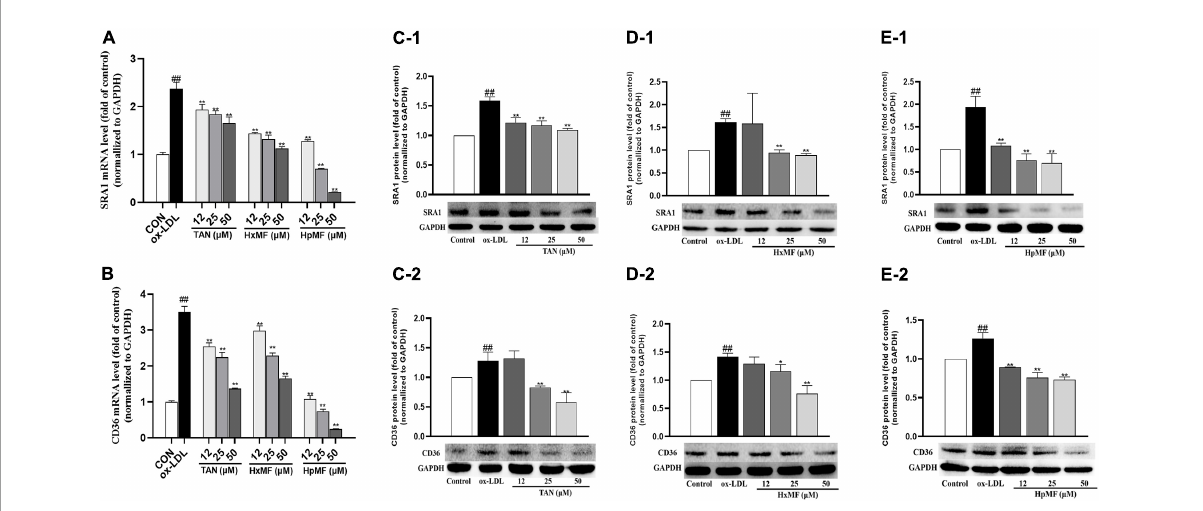
FIGURE5 Effects of TAN, HxMF, and HpMF on mRNA expression of SRA1 in ox-LDL-treated RAW264.7 cells (A) ; effects of TAN, HxMF, and HpMF on mRNA expression of CD36 in ox-LDL-treated RAW264.7 cells (B) ; effects of TAN on SRA1 and CD36 protein expression in ox- LDL-treated RAW264.7 cells (C1,C2) ; effects of HxMF on SRA1 and CD36 protein expression in ox-LDL-treated RAW264.7 cells (D1,D2) ; and effects of HpMF on SRA1 and CD36 protein expression in ox-LDL-treated RAW264.7 cells (E1,E2) . All experiments were run in triplicate, and data showed mean ± SD. ## p < 0.01 compared with the control group, * p < 0.05 and ** p < 0.01 compared with the ox-LDL